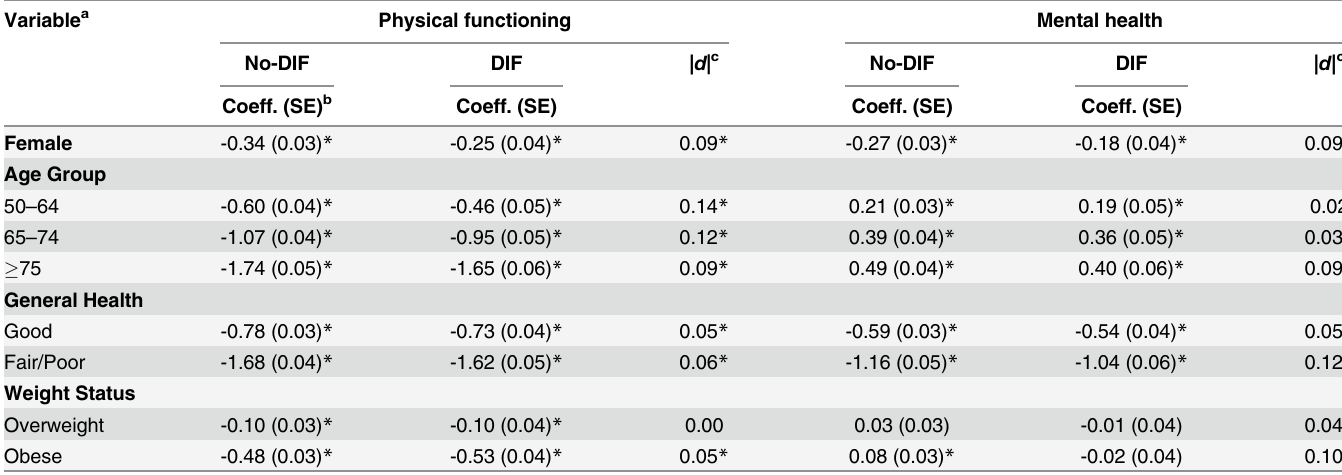
Table 4. Regression coefficient estimates for the effects of demographic and health status variables on physical functioning and mental health latent variables in models without differential item functioning (no-DIF) and with differential item functioning (DIF) in the Canadian Multicentre Osteoporosis